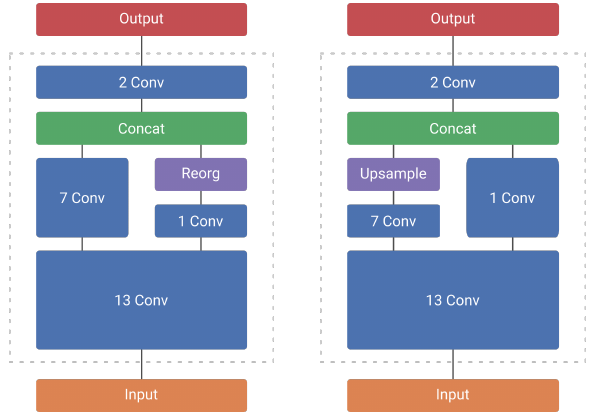
Figure 4. YoloV2 ( left ) and YoloV2 Upsample ( right